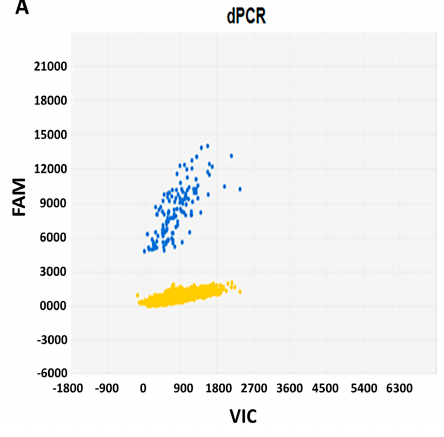
Figure 1. Figure 1. Detection of BRAFV600E by microfluidic digital PCR alone or in combination with COLD- PCR. Each panel represents a single experiment whereby DNA from BCPAP cells was segregated into individual wells and assessed for the presence of the mutant alleles using two different fluorophores (FAM and VIC). The signals from the FAM (blue) and VIC (red) dyes are plotted on the Y axis and the X axis, respectively. The yellow cluster represents the unamplified wells (negative calls). A ) Two-dimensional plots of microfluidic digital PCR reads out of 1 ng DNA extracted from BCPAP cells. Blue cluster represents the wells that were positive for the BRAFV600E mutation. B ) Results of dPCR analysis after the enrichment of BRAFV600E by COLD-PCR demonstrating 100-fold increase in mutant alleles (blue cluster). dPCR, digital Polymerase chain reaction; COLD, co-amplification at lower denaturation temperature; PCR, Polymerase chain reaction; FAM, fluorescein; VIC, 2 ′ -chloro-7 ′ phenyl-1,4-dichloro-6-carboxy-fluorescein. 3.2. Clinicopathologic Characteristics of BRAFV600E Positive Thyroid Cancers The study cohort consisted of 57 patients with BRAFV600E -positive PTCs, followed for a median of 27 (IQR 16.5–51) months. Of these, 40 (70%) were women, and 17 (30%) were men. The average age of patients was 46 years, ranging from 21 to 82 years. The final pathology revealed a thyroid cancer diagnosis in all patients, including 38 patients with classical PTC (CPTC), 13 with tall cell variant PTC (TCPTC), and six with follicular variant PTC (FVPTC). In one case in addition to CPTC, a micro-medullary thyroid cancer was detected. The average tumor size was 2.4 ± 1.8 cm, with a multifocal growth pattern found in 34/57 (59.6%) cases and gross extension in 13/57 (22.8%) cases. Lymph node metastases to the central neck and lateral neck compartments were detected in 31/57 (54%) and 18/57 (31%) cases, respectively. Distant metastases were found in 12 patients (in 10 individuals in lungs and two cases in bones). There were 19 patients with low-risk thyroid cancer, 22 patients with intermediate-risk tumors, and in 16 cases the tumors were classified as high-risk PTCs. 3.3. Detection of cfBRAFV600E in Serum from Patients with Low-, Intermediate- and High–Risk PTCs. Microfluidic digital PCR allowed the detection of cf BRAFV600E in the DNA extracted from 8/57 (14%) patients. The ratios of the mutant vs. wild-type BRAF alleles ranged from 0.6% to 6.9%. By microfluidic dPCR, cf BRAFV600E alleles were found in seven patients with high-risk PTCs and one patient with intermediate-risk PTC. The combination of microfluidic dPCR with COLD-PCR allowed the detection of circulating cf BRAFV600E in 24/57 (42.1%) examined patients. Clinicopathological characteristics of the cases in which circulating cf BRAFV600E was detected and the cases in which wild-type BRAF was detected are summarized and compared in Table 1.